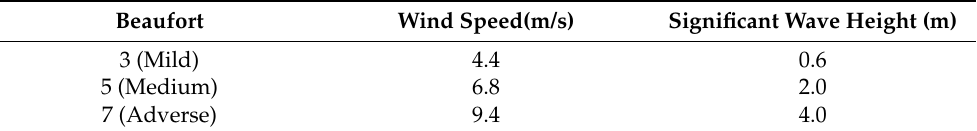
Table 5. Designed environmental condition (mild, medium, and adverse